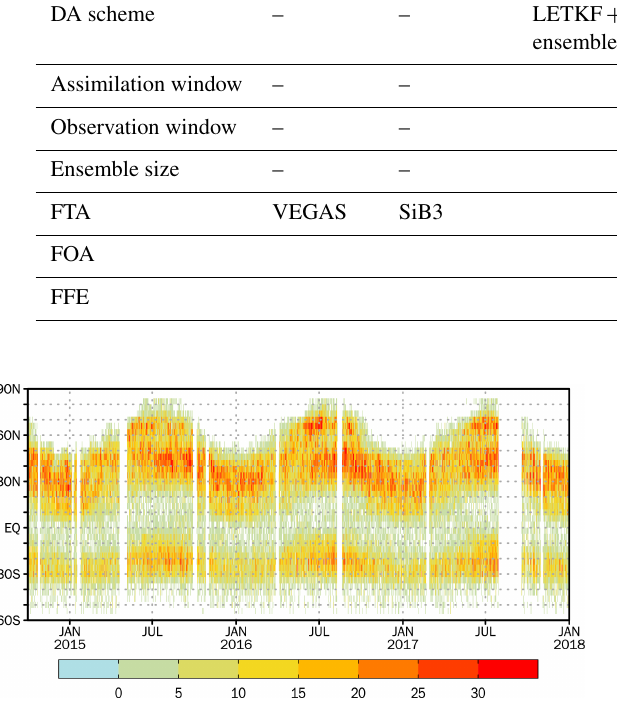
Figure 4. The daily pseudo OCO-2 land nadir and land glint obser- vation numbers along the 4 ◦ latitude